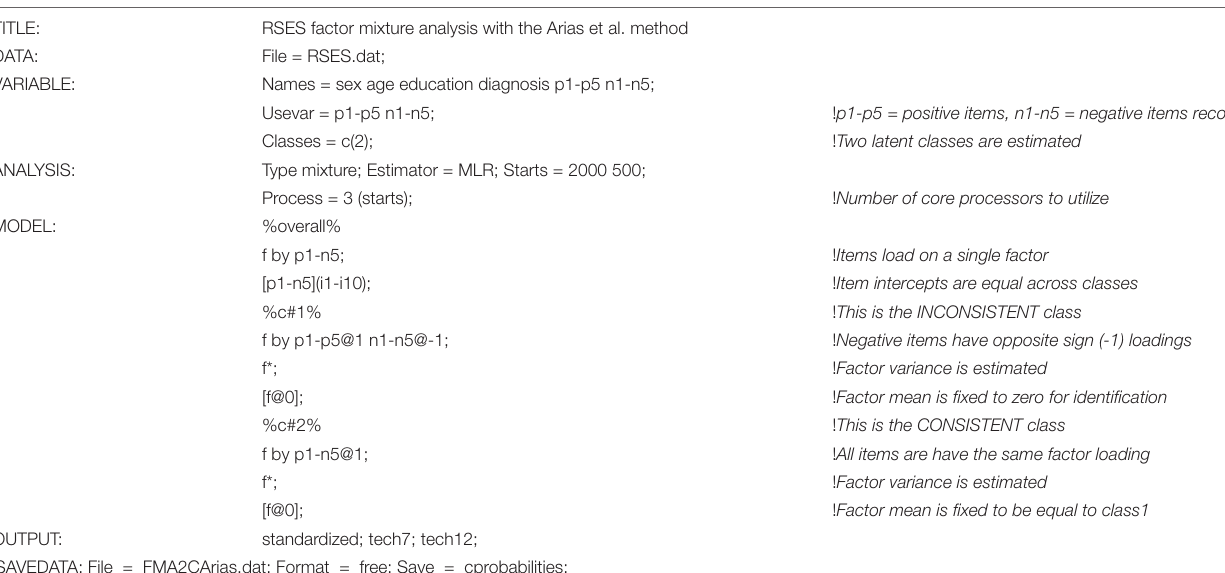
TABLE A2 | M plus Syntax for the Factor Mixture Analysis with the Arias et al.